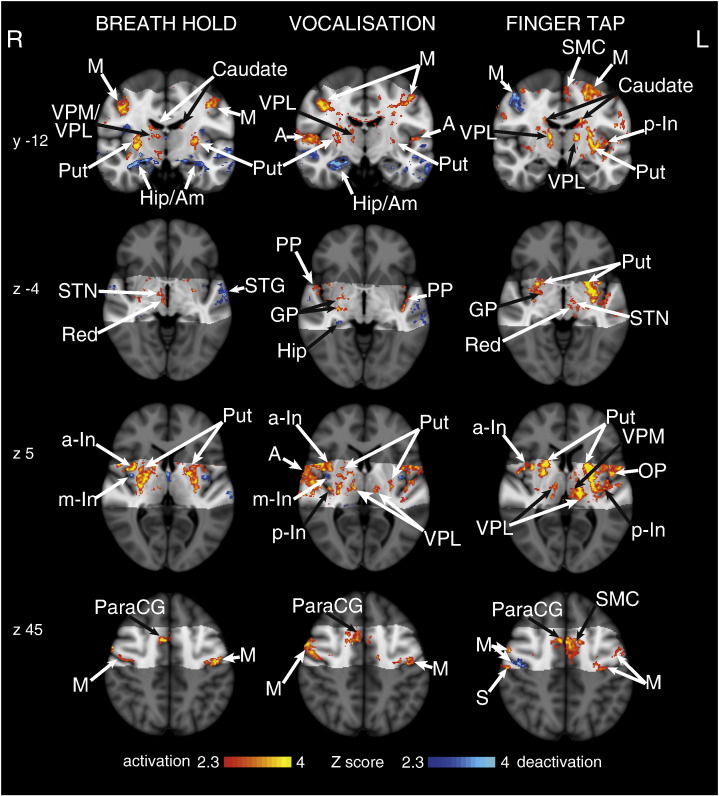
BOLD response to breath holds, vocalisations and finger opposition in 15 subjects, having accounted for CO2-induced vasodilation. The images consist of a colour-rendered statistical map superimposed on a standard (MNI 1 mm3) brain. The bright grey region represents the coverage of the coronal-oblique functional scan. Significant regions are displayed with a threshold Z > 2.3, with a cluster probability threshold of p < 0.05 (corrected for multiple comparisons). Abbreviations: M, motor cortex; Caudate, caudate nucleus; SMC, supplementary motor cortex; Put, putamen; A, auditory cortex; Hip, hippocampus; Am, amygdala; thalamic nuclei: VPM, ventral posteromedial nucleus; VPL, ventral posterolateral nucleus; MDN, medial dorsal nuclei; a-In, anterior insula; m-In, middle insula; p-In, posterior insula; PP, planum polare; STN, subthalamic nucleus; Red, Red nucleus; STG, superior temporal gyrus; GP, globus pallidus; OP, operculum; S, post central gyrus (sensory cortex); paraCG, paracingulate gyrus; activation, increase in BOLD signal; deactivation, decrease in BOLD signal. R (right) and L (left) indicate image orientation.